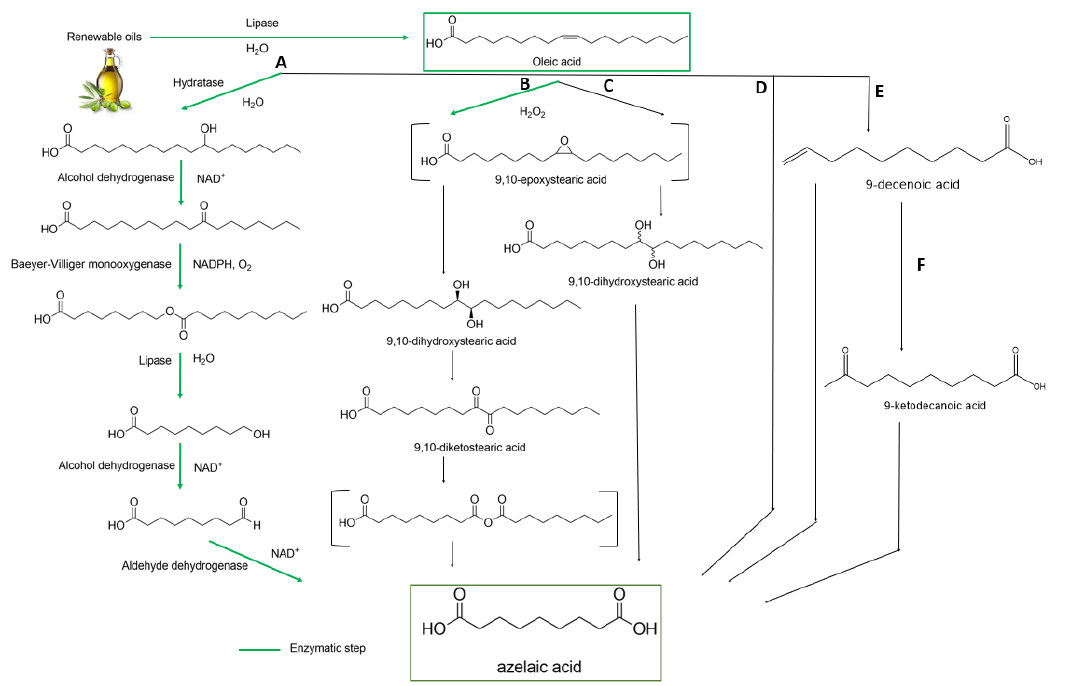
Figure 1. The main routes reported for synthesis of azelaic acid starting from oleic acid: A — enzymatic route [39], B — chemo-enzymatic route [2], C — two step route with epoxide [34], D — direct cleavage, E — two step pathway with metathesis of oleic acid, F — three step route [28].